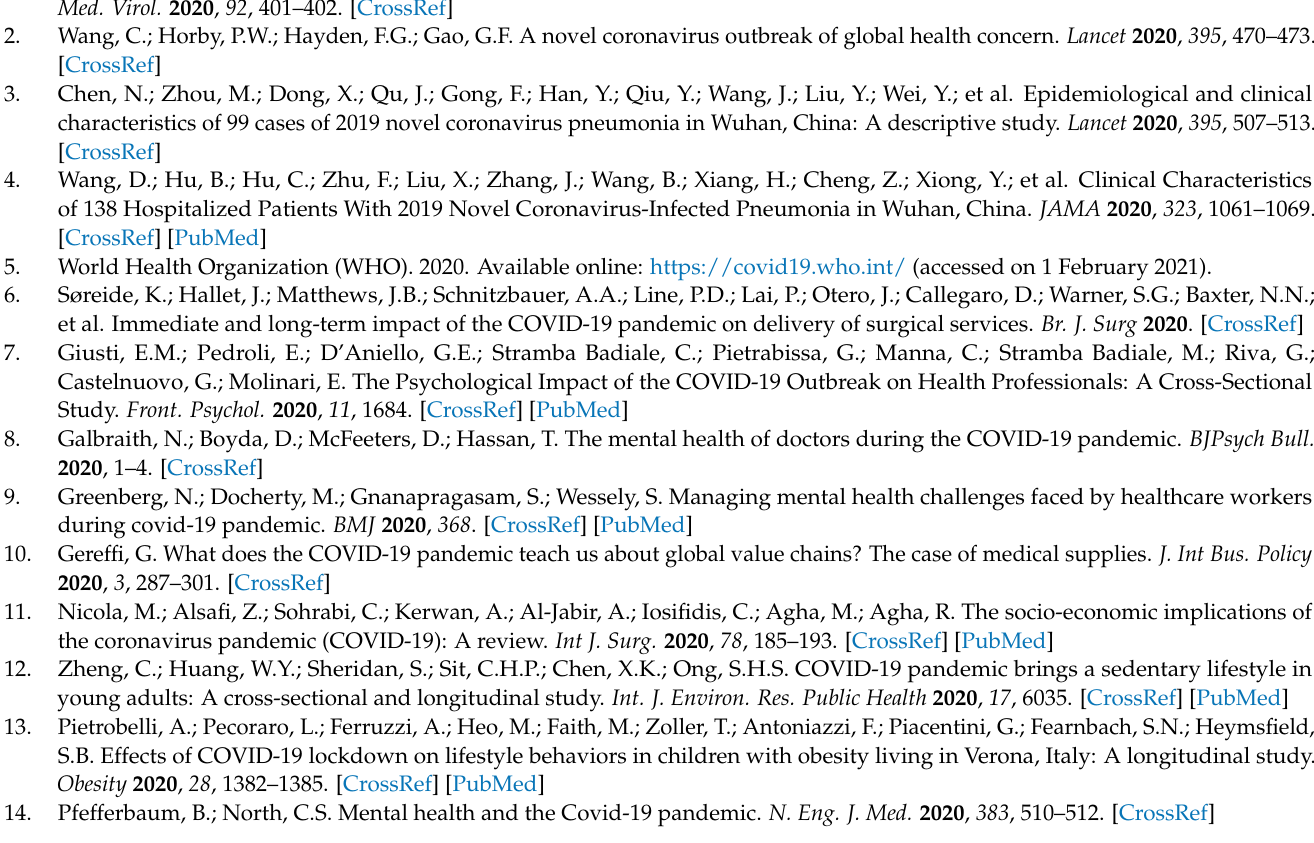
Table S3: EFA: Results and factor loadings of economic effects of COVID-19; Table S4: EFA: Results and factor loadings of emotions; Table S5: EFA: Results and factor loadings of change in the use of public